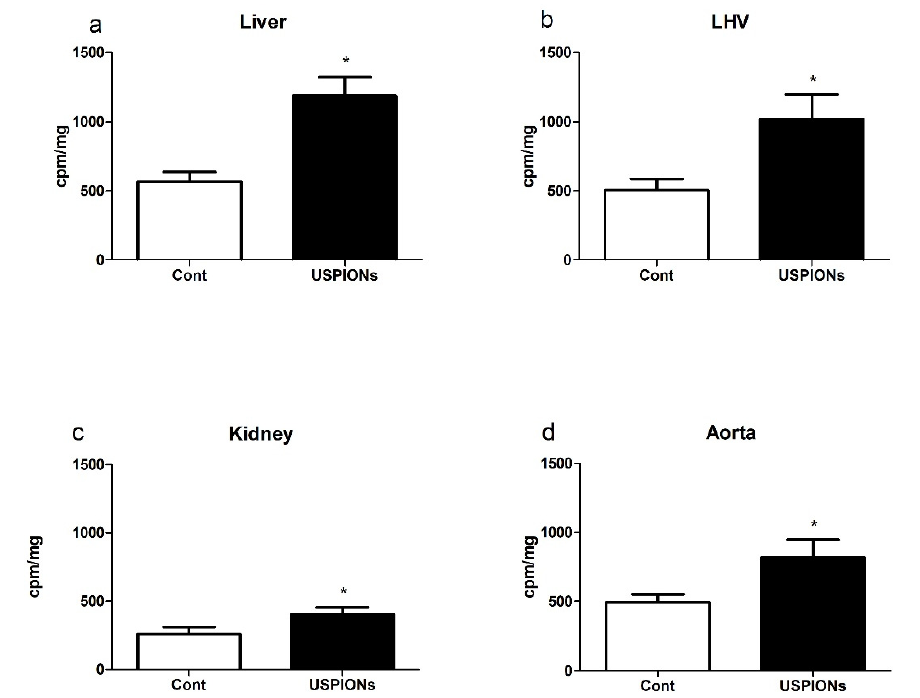
Figure 19. Superoxide production ( a ) in the liver, ( b ) left heart ventricle (LHV), ( c ) kidney and ( d ) aorta. The values represent the mean ± SEM. * p < 0.05 vs. control (Cont) group.